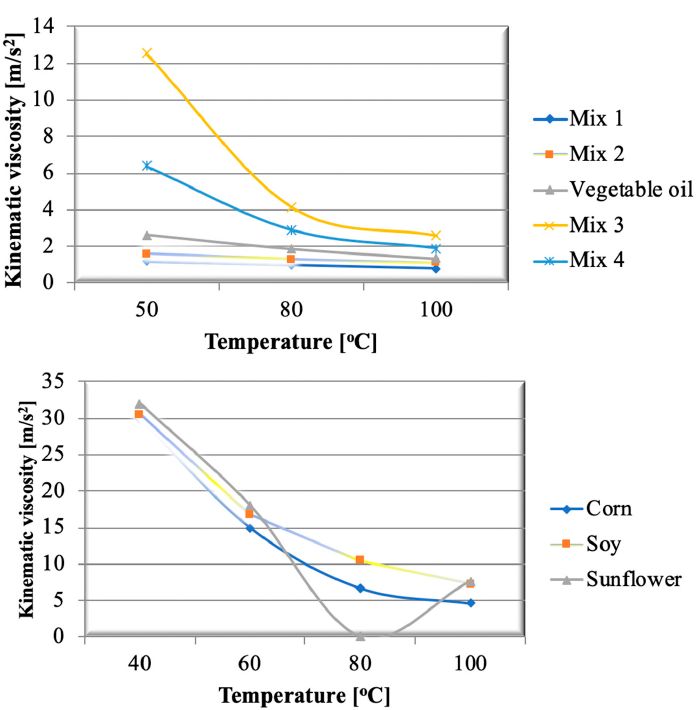
Figure 7. Kinematic viscosity comparison.